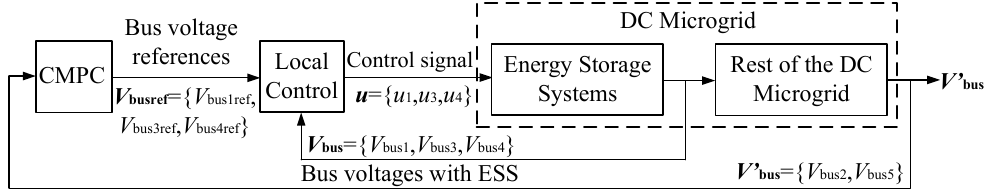
Energies 2019 , 12 , x FOR PEER REVIEW Figure 12. Overall control block diagram of multiple ESS in the five-bus standalone DC microgrid.